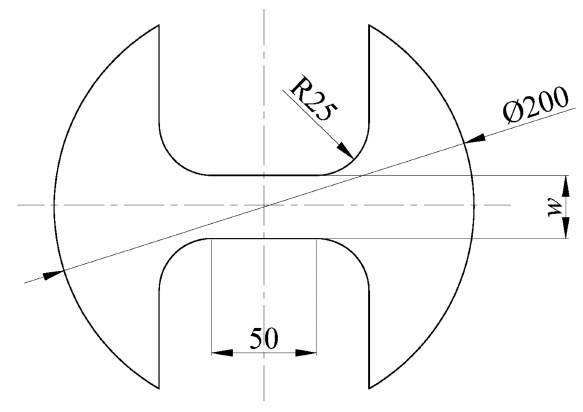
Figure 7. The geometry and size of the blank (unit: